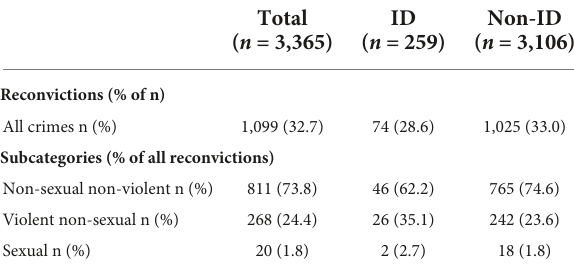
TABLE 3 Reconvictions at end of follow-up among offenders with and without ID.